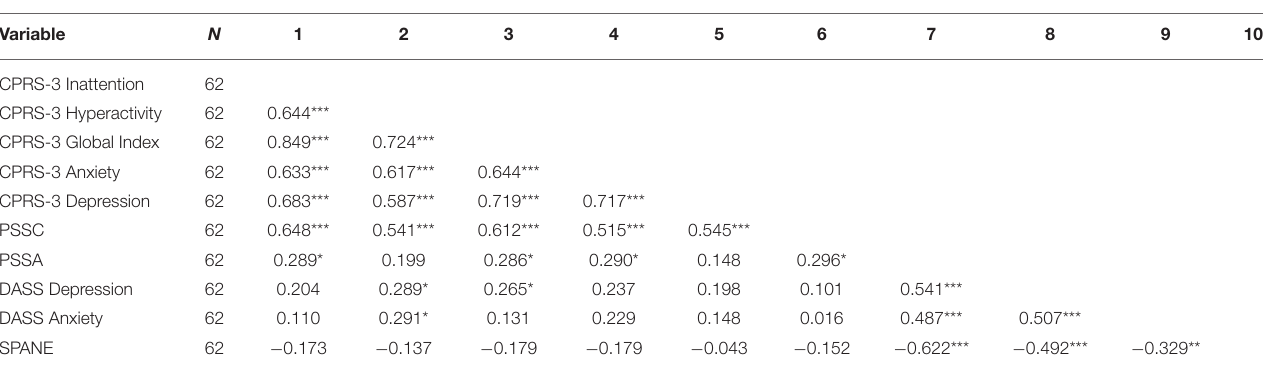
TABLE 7 | Correlation between mid-lockdown scores in children’s behavior and psychological distress as well as parents’ psychological distress and well-being (TD group).